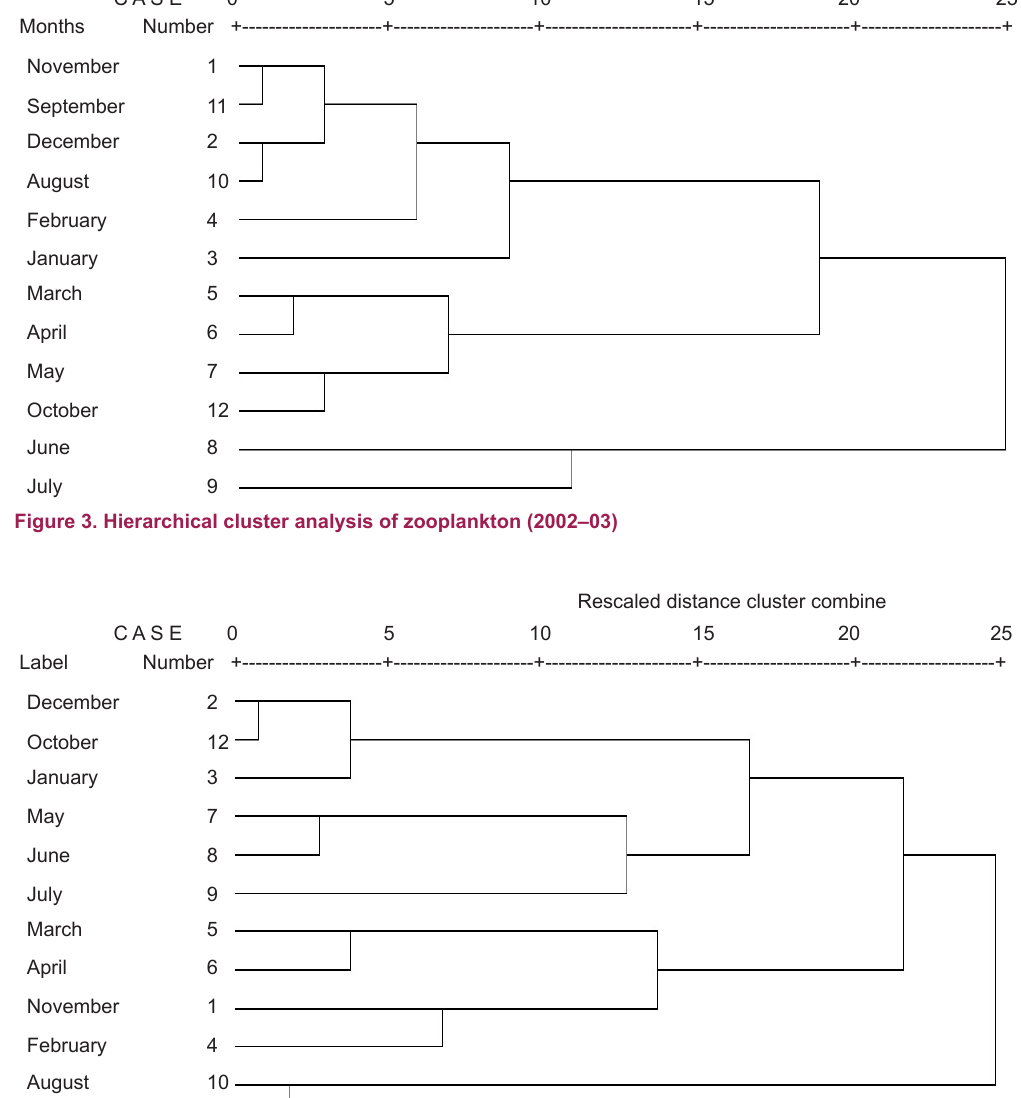
Figure 4. Hierarchical cluster analysis of zooplankton (2003–04)